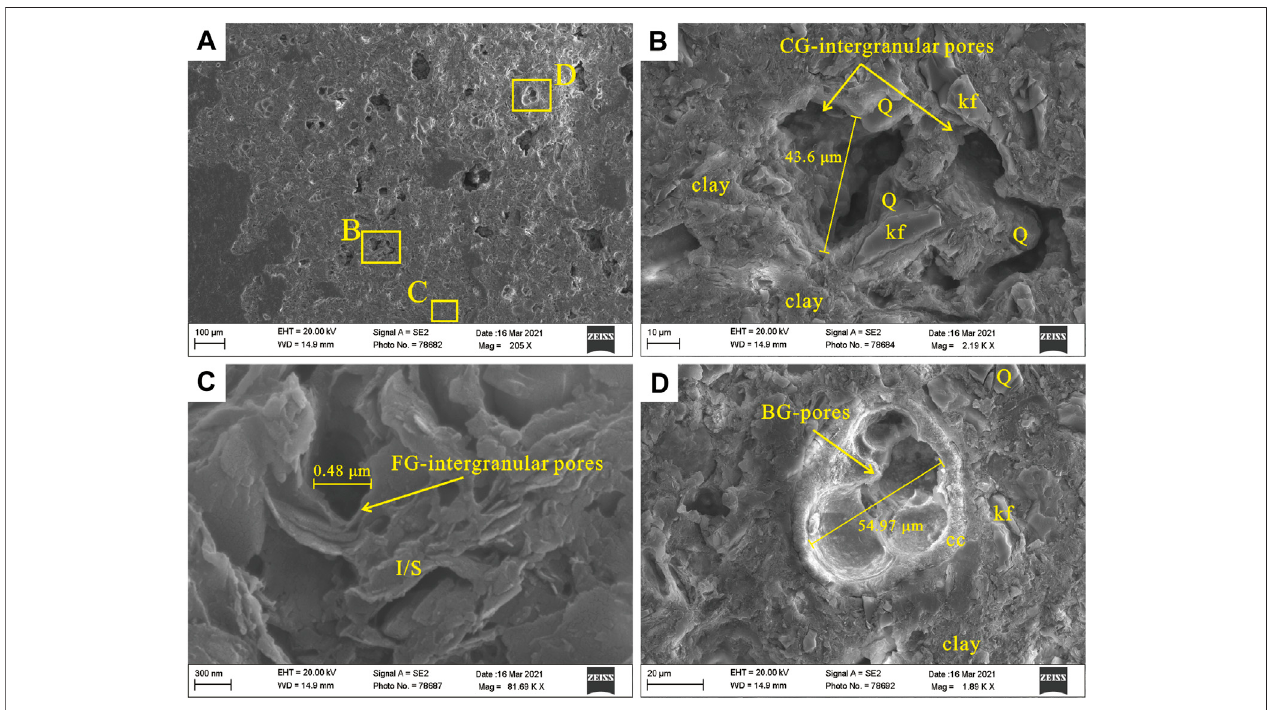
FIGURE5| Poresstructurecharacteristicsingashydratereservoir. (A) SiteW19,136.10mbsf,SEMimage; (B) , (C) ,and (D) enlargetheyellowboxin fi gure (A) .Q, kf, cc, clay, and I/S are short for quartz, K-feldspar, calcite, clay minerals, and illite/semectite, respectively.